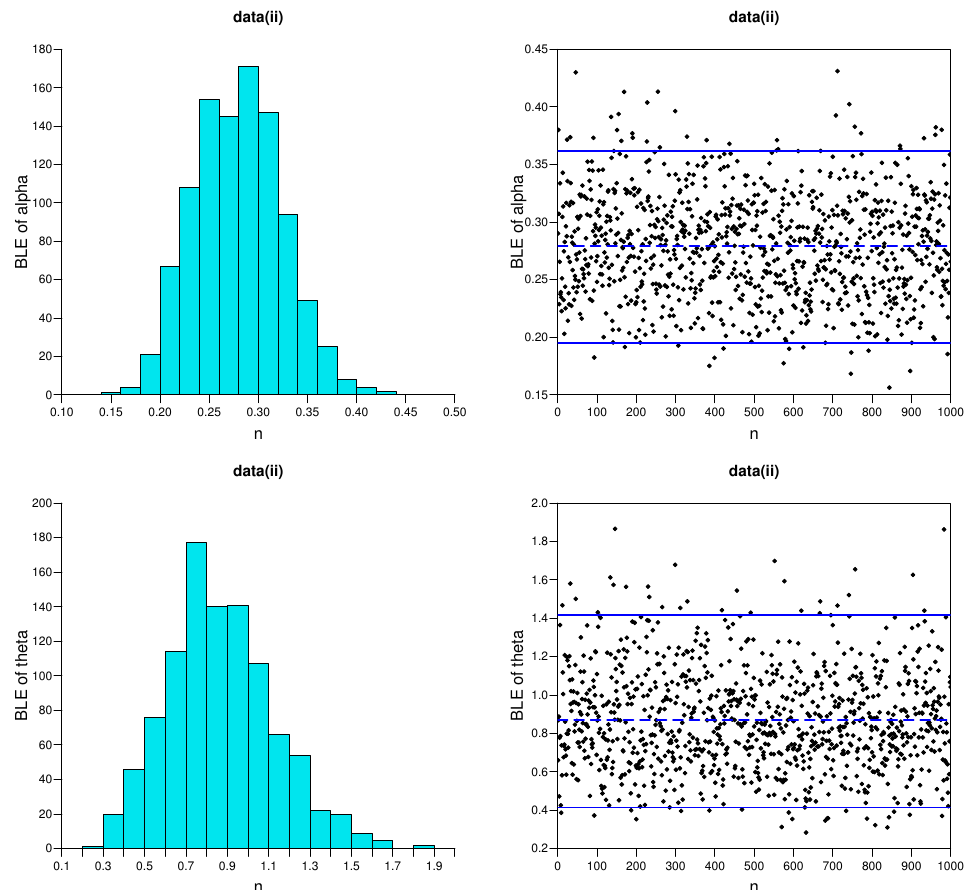
Figure 8. Trace plots (the posterior mean (dashed line) with 95% credible intervals (solid lines)) and corresponding histograms of BLEs of α and θ for data set